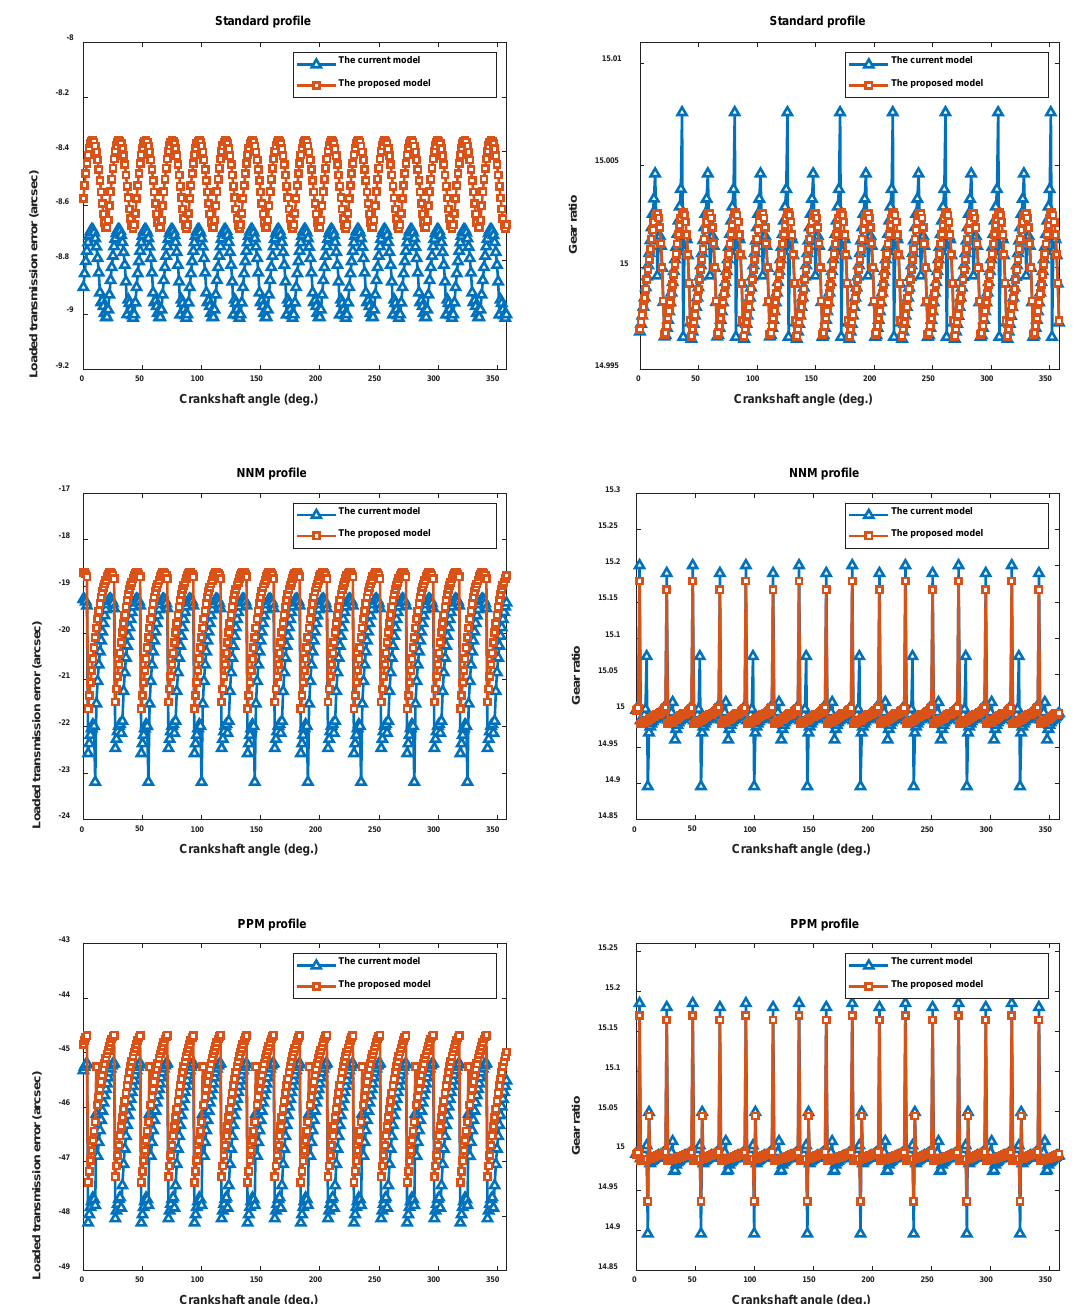
Figure 10. Comparison of loaded transmission error and gear ratio in a mesh circle obtained by the current model and the proposed model for the cases of standard, NNM, and PPM profiles.